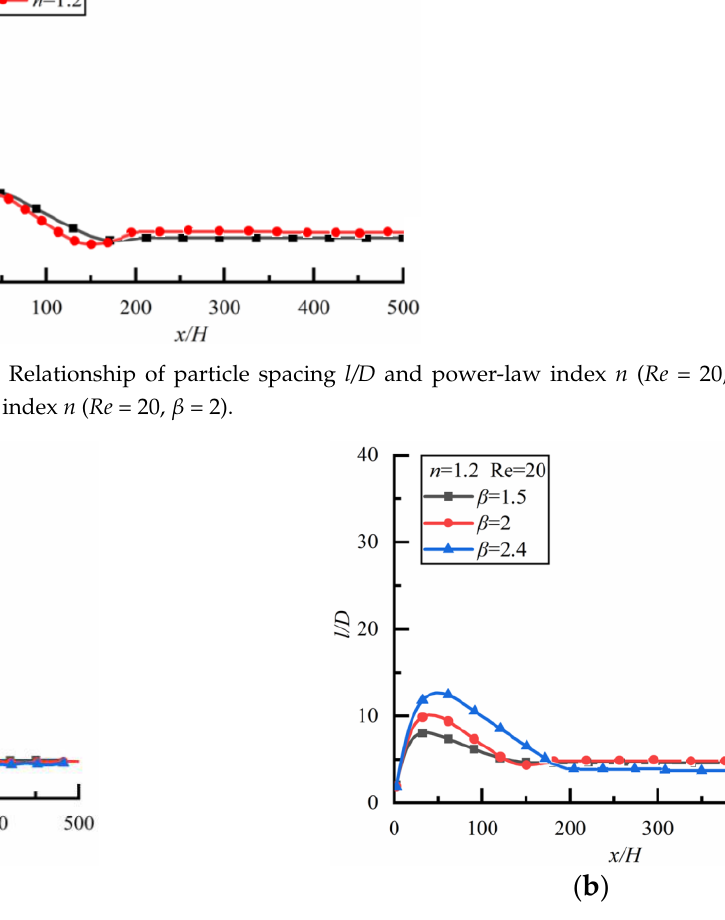
Figure 15. Relationship of particle spacing l/D and diameter ratio β ( Re =20). ( a ) n =0.8, ( b ) n =1.2.